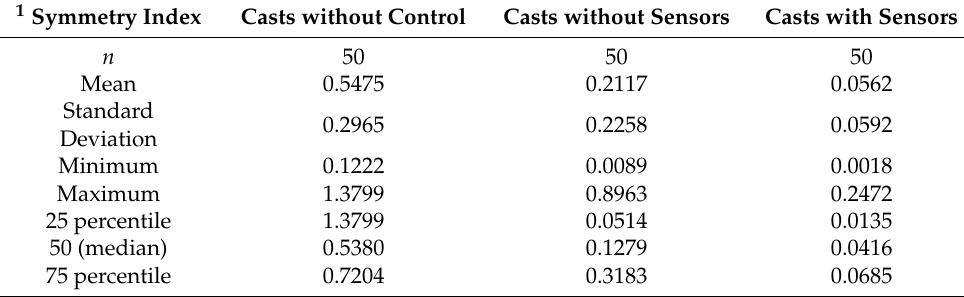
Table 1. Descriptive statistics of the “Symmetry Index” in the three study groups.